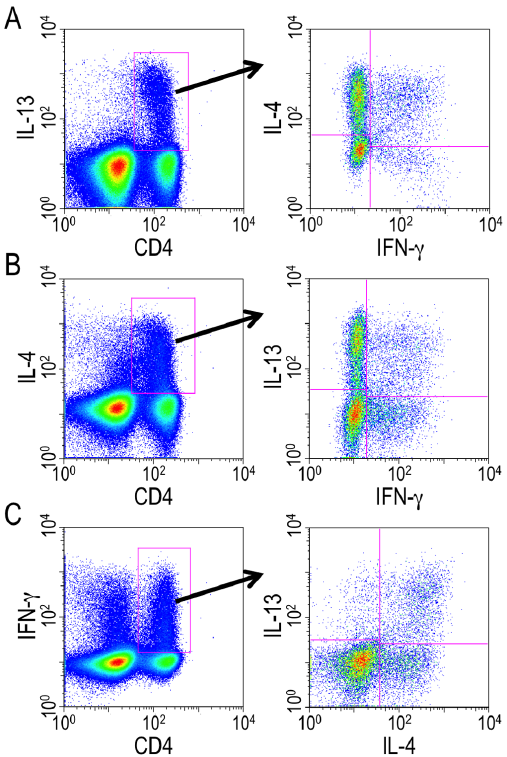
Figure 4. The unique hepatic T cells exhbited the ability to produce IFN- c , IL-13, and IL-4 simultaneouly. Hepatic lympho- cytes were isolated from S. mansoni -infected mice at 6 weeks PI and ICS was conducted after TCR stimulation. c 4 cells within IL-13-producing CD4 + T cell population (A), c 13 cells within IL-4-producing CD4 + T cell population (B), and IL-4- and IL-13-secreting cells within IFN- c - producing CD4 + T cell population (C) were analyzed. Data shown are a representative of five independent